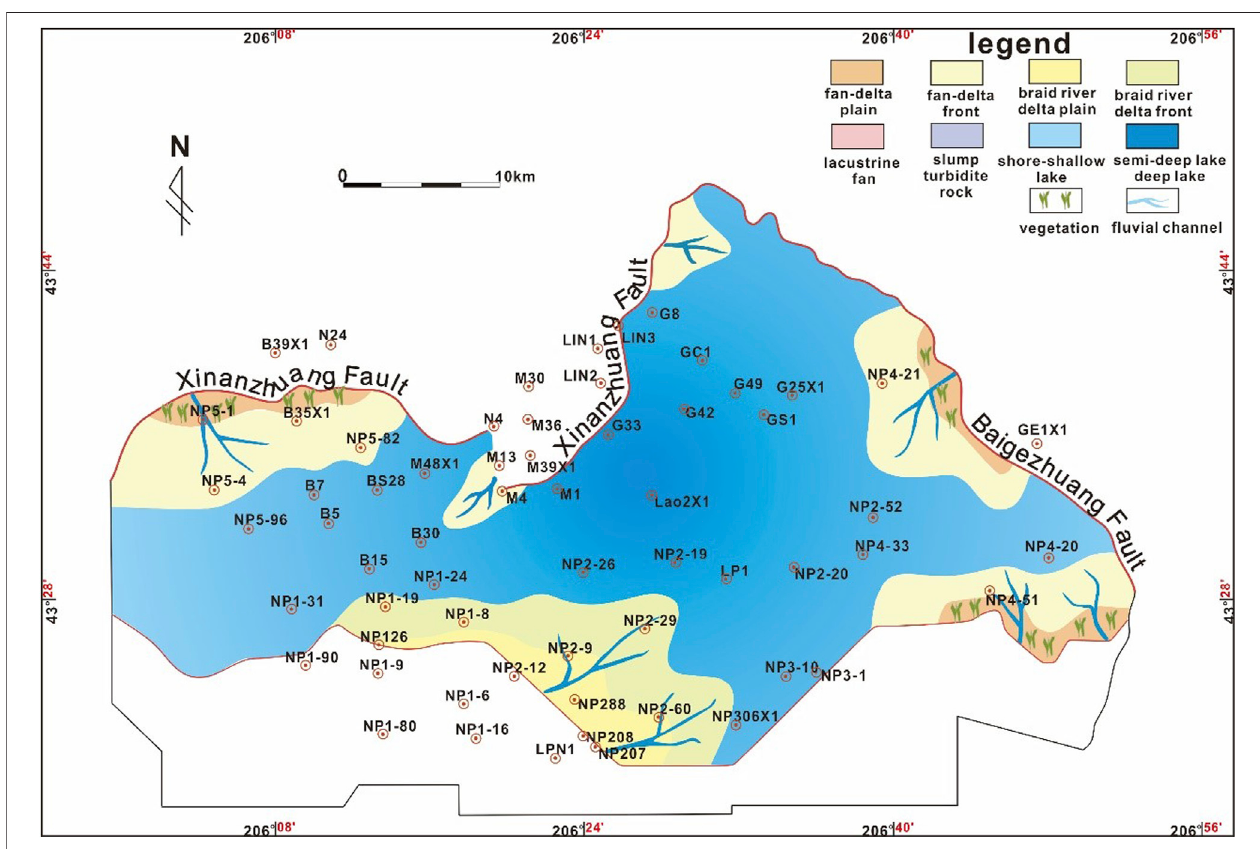
FIGURE 5 | Plane distribution map of the E s 34+5 sedimentary system in Nanpu